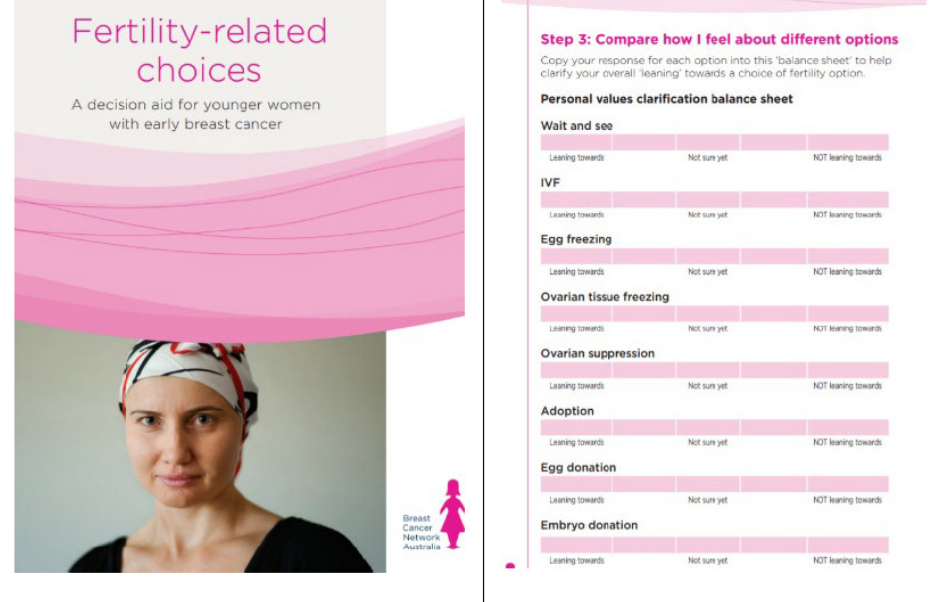
Figure 2. Fertility-related choices: A decision aid for younger women with early breast cancer. Permission from Dr. Michelle Peate, The University of Melbourne.